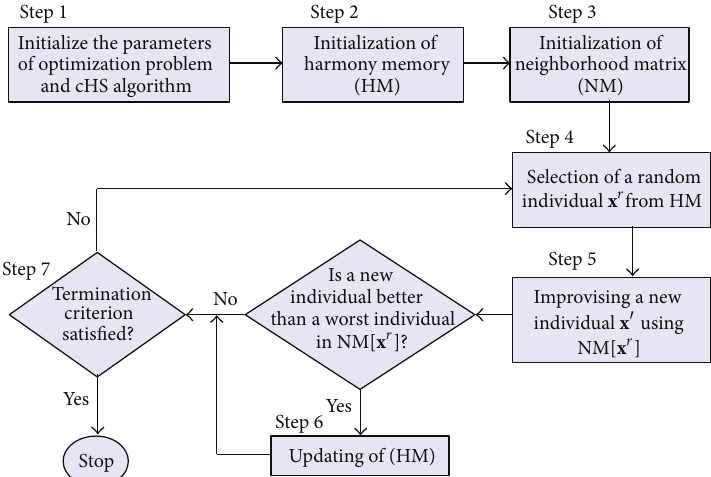
Figure 2: The flowchart of cHS.